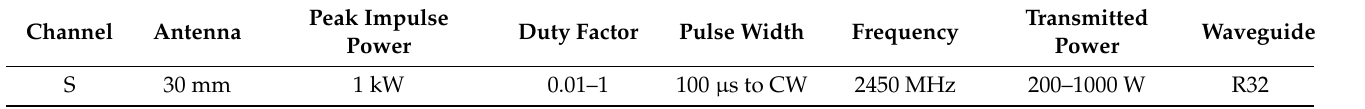
Table 2. Basic parameters of an optimized microwave power